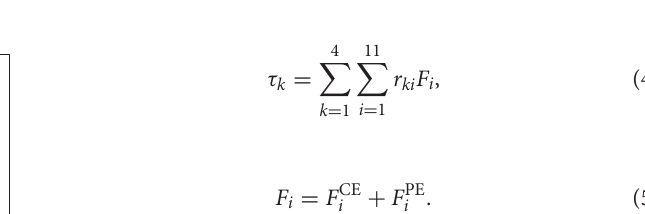
FIGURE 1 | Four-link skeletal model. (A) Is the skeletal model representing body segments of shank, thigh, pelvis, and HAT (head, arm, and truck); connected by four joints: ankle, knee, hip, and lumbar. (B) Shows the definitions of joint angles and joint torques.